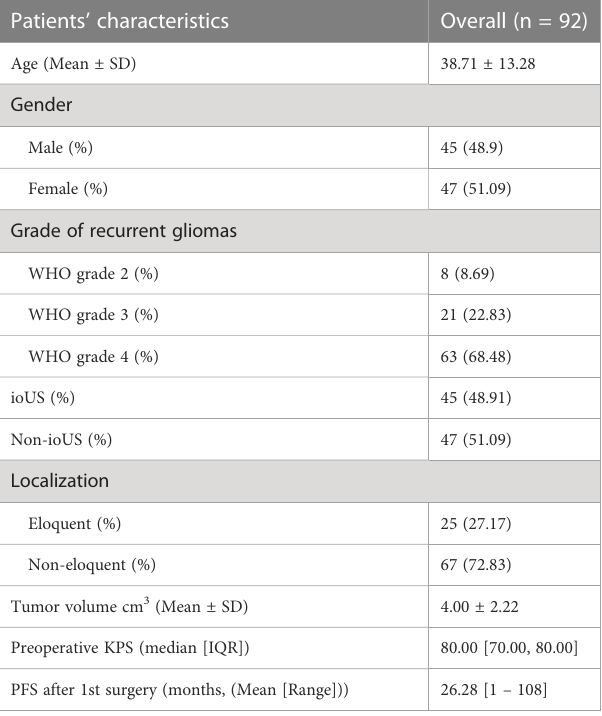
TABLE 1 Preoperative overall characteristics of patients with recurrent gliomas. Patients ’